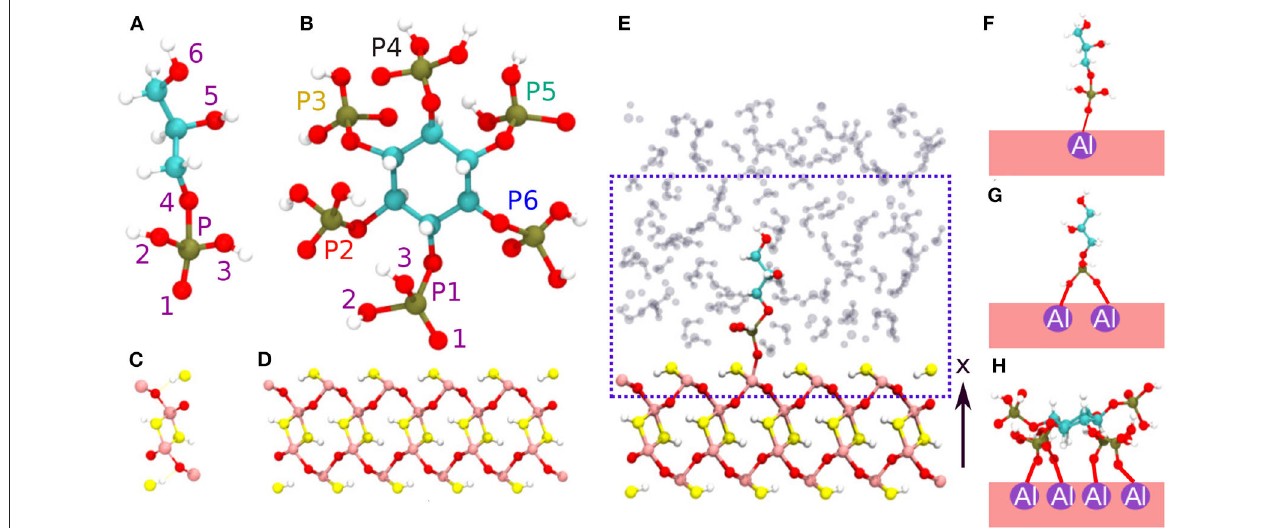
FIGURE 1 | Phosphates GP (A) and IHP (B) . The oxygen and phosphorus atoms are labeled here to ease the discussion of diaspore–IHP/GP–water interactions. Diaspore unit cell (C) , side view of the modeled diaspore surface (D) , diaspore–GP–water complex and the blue box including atoms described at quantum mechanical level of theory (QM part) and remaining atoms at molecular mechanics level (MM part) (E) , M motif (F) , B motif (G) , 4M motif (H) . Pink, red, yellow, white, lime, and cyan colors correspond to Al, bridging oxygen, hydroxyl oxygen, hydrogen, phosphorus, and carbon, respectively.